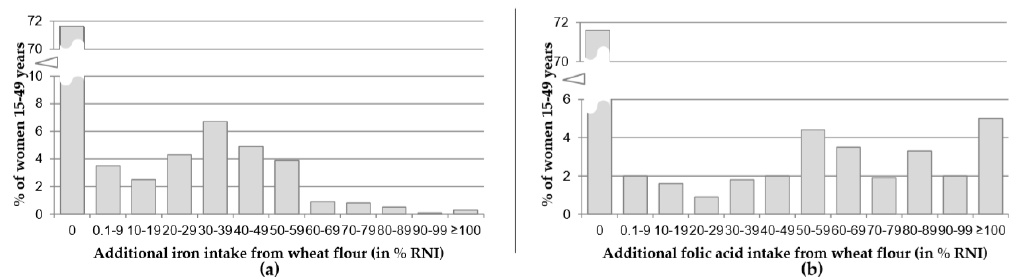
Figure 2 Additional iron (a) and folic acid (b) intake from fortified wheat flour for NPW, expressed as % of the reference nutrient intake (RNI), Uzbekistan